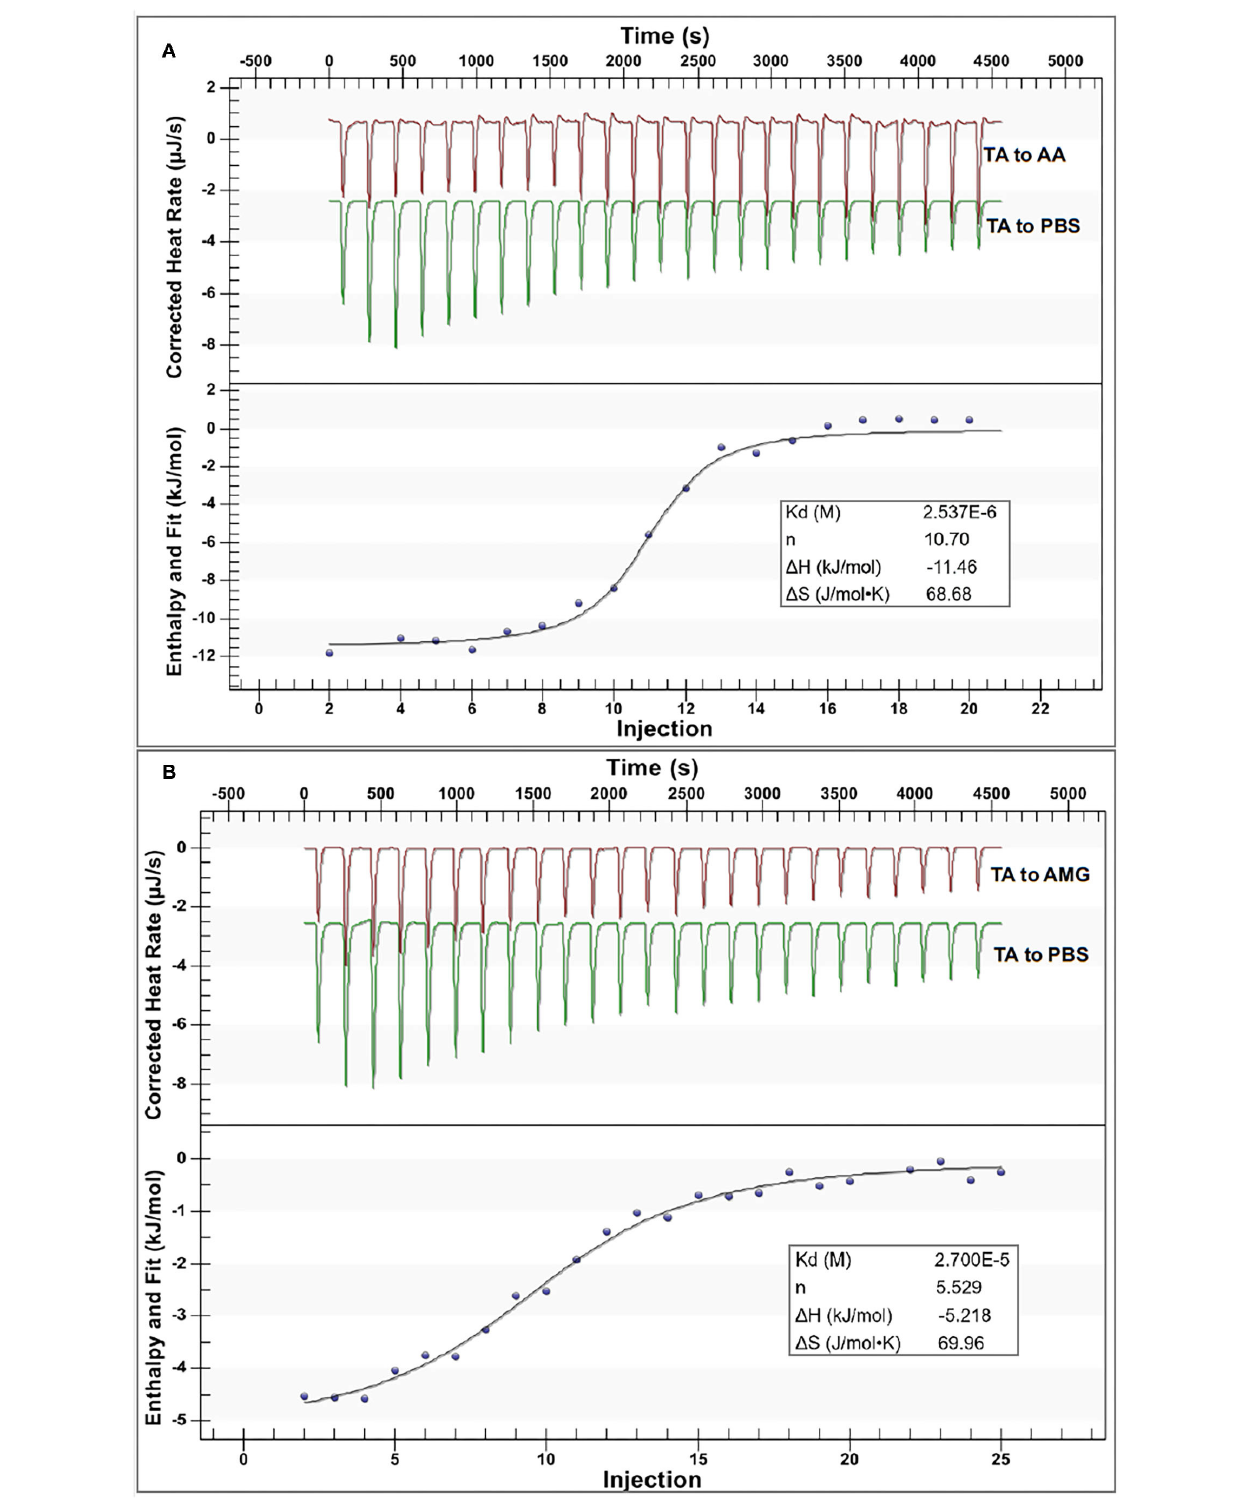
FIGURE 4 | The isothermal titration calorimetry (ITC) data for binding interactions between TA and AA (A) and that between TA and AMG (B) ; in each figure, the upper section indicates the heat flow for titration of TA to the enzyme solution (the red curves) and titration of TA to buffer (the green curves), and the lower section indicates the fitted plots of the enthalpy changes against the injection order by the use of an independent binding model equation. Notably, the applied molar ratios of TA to the enzymes were modified within the available ranges to make the model fit the curves more suitably.